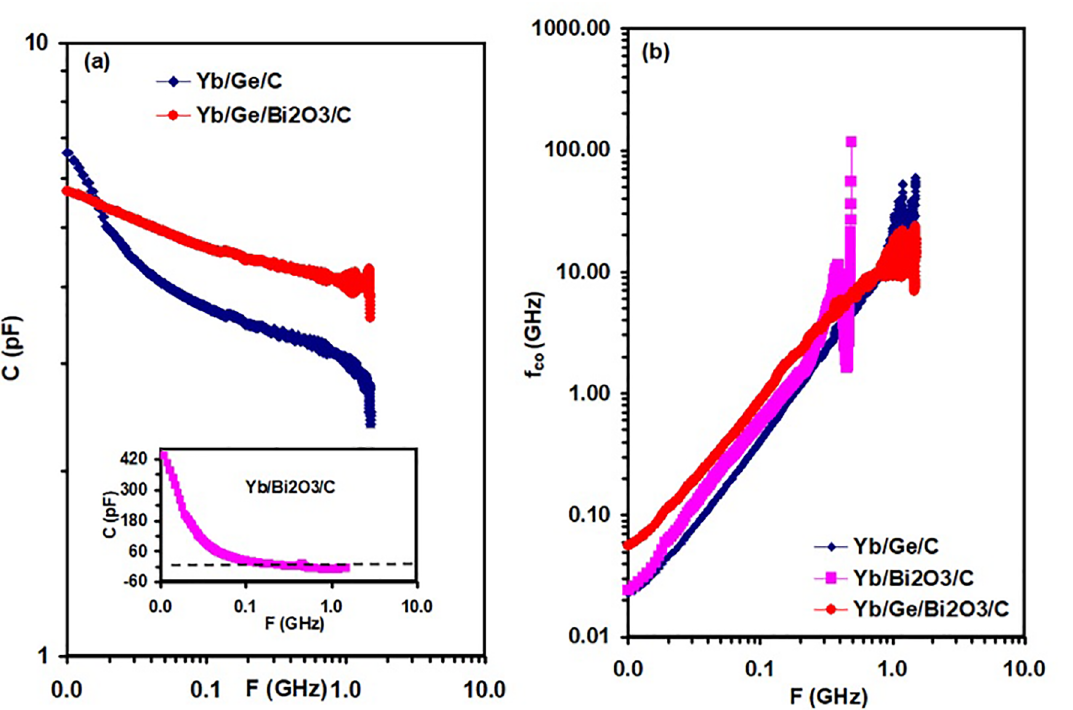
O /C channels. The inset of (a) 2 3